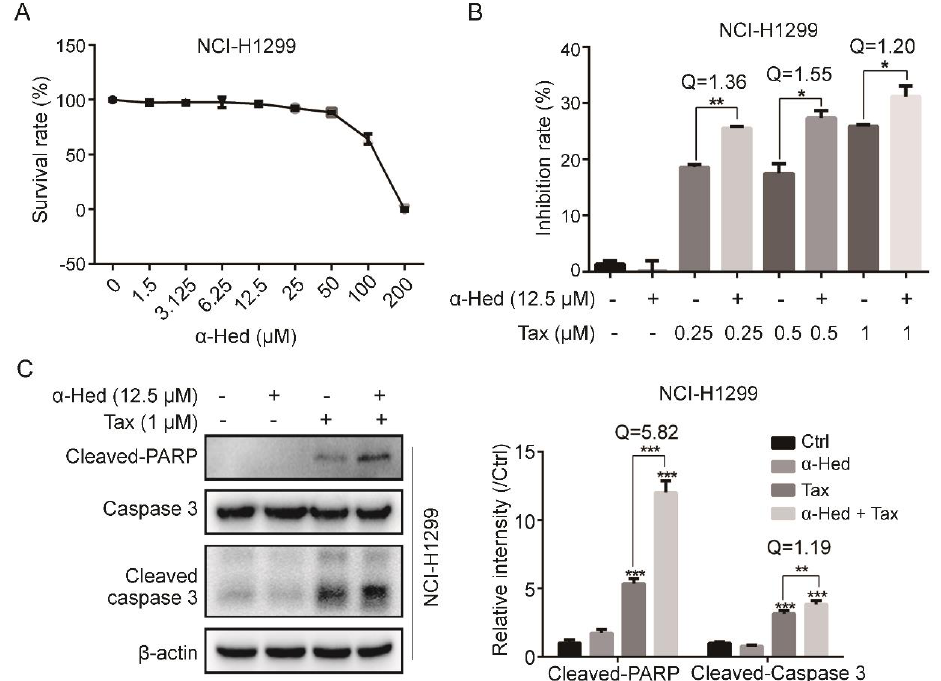
Figure 5. α -Hed increased the Tax-induced inhibition of proliferation and apoptosis in human NSCLC cells. ( A ) Effect of α -Hed on the NCI-H1299 cell survival rate. Cells were treated by α -Hed for 24 h. ( B ) α -Hed increased Tax-induced proliferative inhibition. * p < 0.05, ** p < 0.01. Q value > 1.15 indicted a synergistic effect. ( C ) α -Hed increased Tax-induced apoptosis. Cleaved-PARP, caspase 3, and Cleaved-caspase 3 expression levels were detected with western blotting. ** p < 0.01, *** p < 0.001. Q value > 1.15 indicates a synergistic effect.